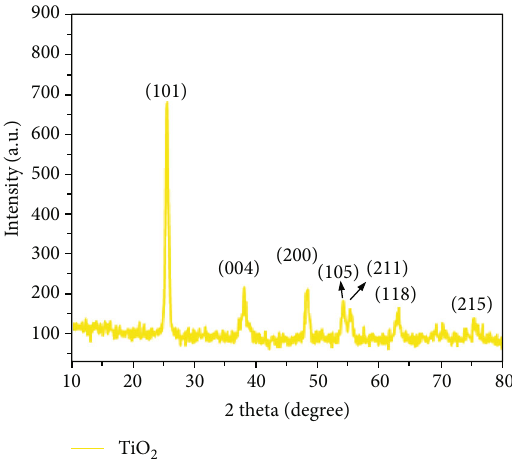
Figure 4: XRD crystalline nature of the synthesized TiO nanoparticles.